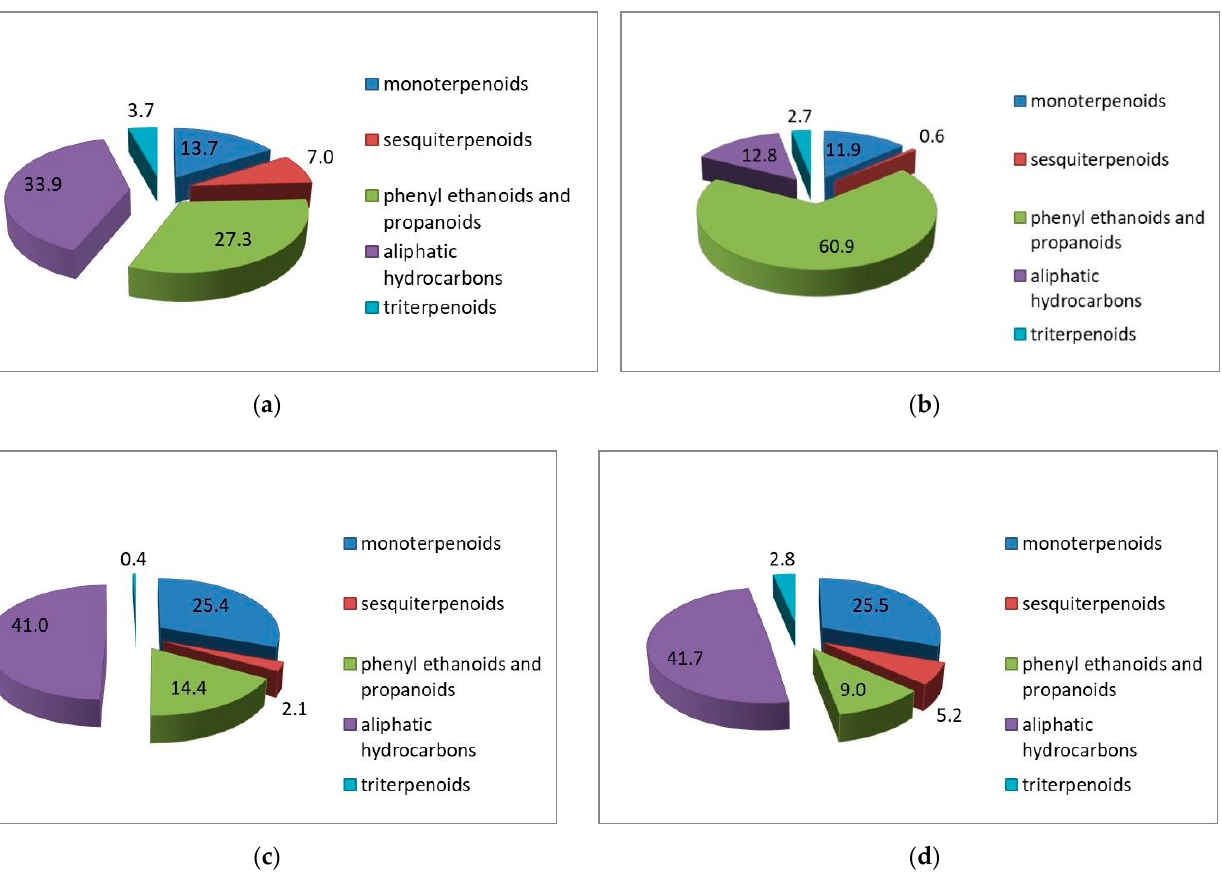
Figure 2. Main chemical classes distribution, according to the data from Table 1: ( a ) R. gallica , ( b ) R. damascena , ( c ) R. alba and ( d ) R. centifolia.